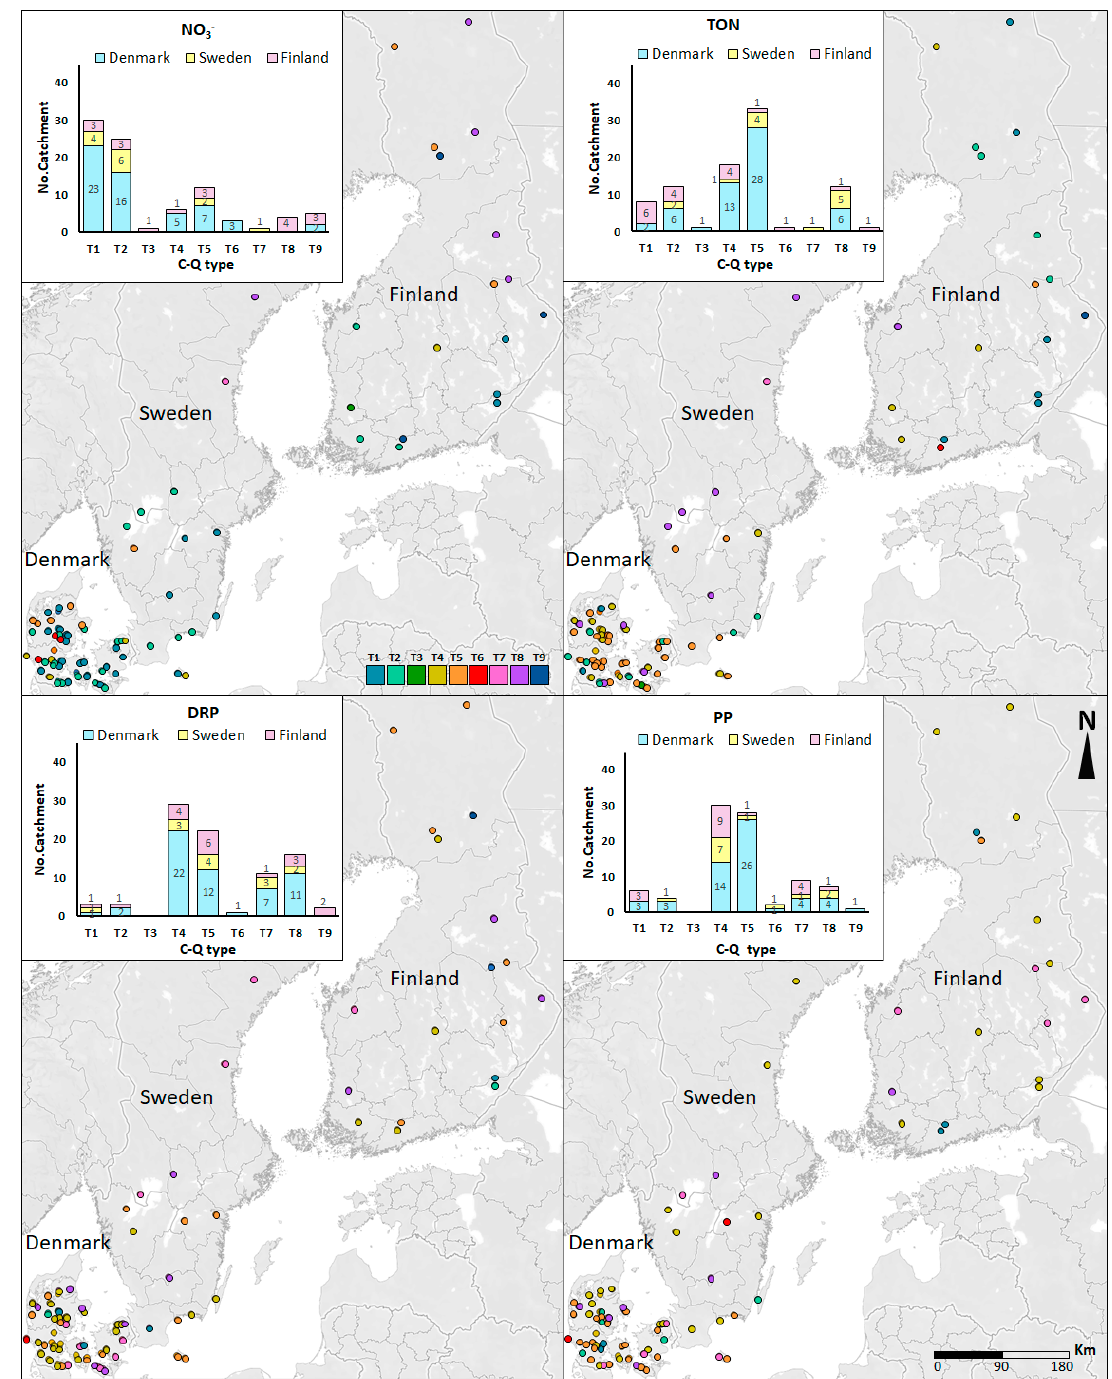
Figure 3. C-Q relationship types (T1–T9) characterising mini-catchments in three Nordic countries: Denmark, Sweden, and Finland, including nitrate (NO 3 − ), total organic N (TON), dissolved reactive P (DRP), and particulate P (PP), considering export regime (enrichment, constant, and dilution) and hysteresis patterns (clockwise, anticlockwise, and no